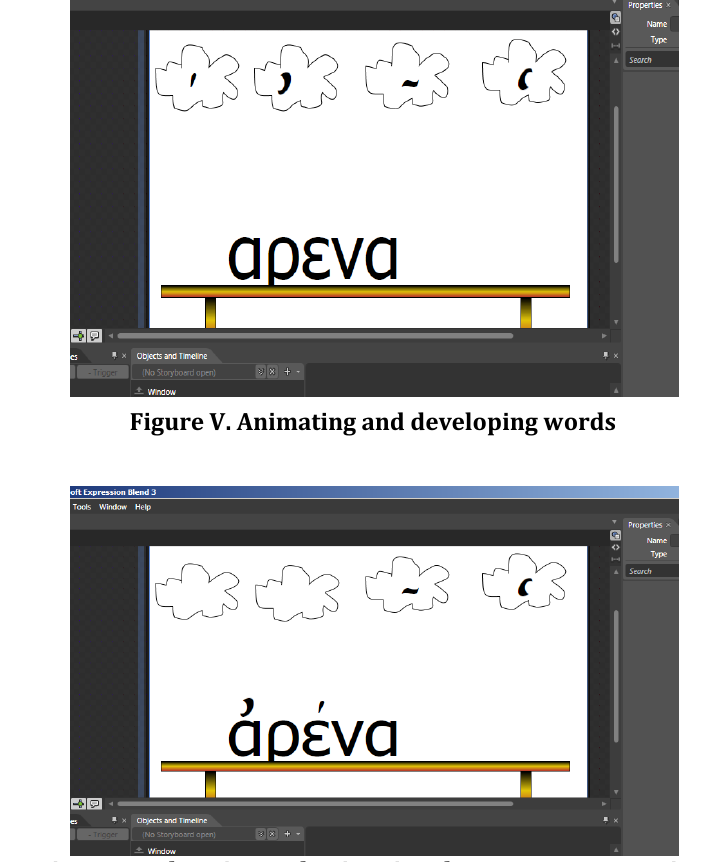
Figure VI. Choosing and animating the correct punctuation